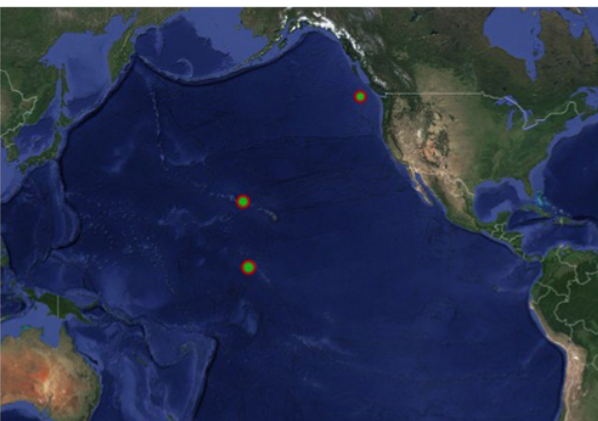
Figure 1. Sampling locations of three expeditions from which coral specimens were collected by deep-sea submersible diving. Lo- cations approximate Warwick Seamount, Gulf of Alaska (DSRV Alvin , 2004), Hawaiian and Northwest Hawaiian Islands (DSRV Pisces V , 2005 and 2007), and Line Islands (DSRV Pisces IV ,